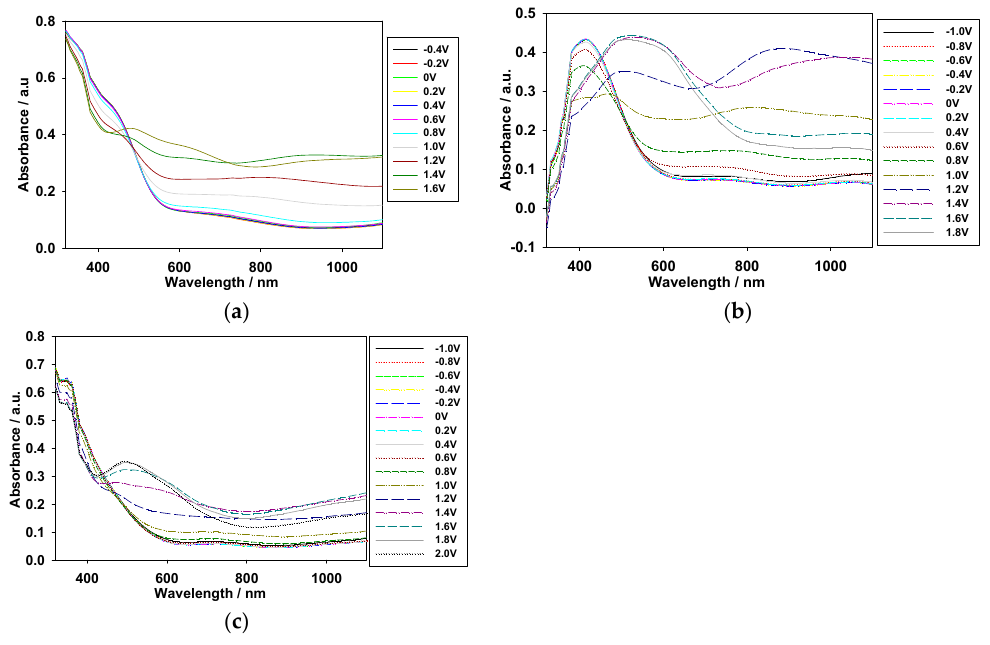
Figure 4. Spectroelectrochemical spectra of ( a ) PMPS; ( b ) PMPO; and ( c ) PANIL films on an ITO electrode at different potentials in [EPI + ][TFSI − ] solution. Table 1. Electrochromic behaviors of PMPS, PMPO, and PANIL films in [EPI + ][TFSI − ] solution at 0 V and +1.6 V.